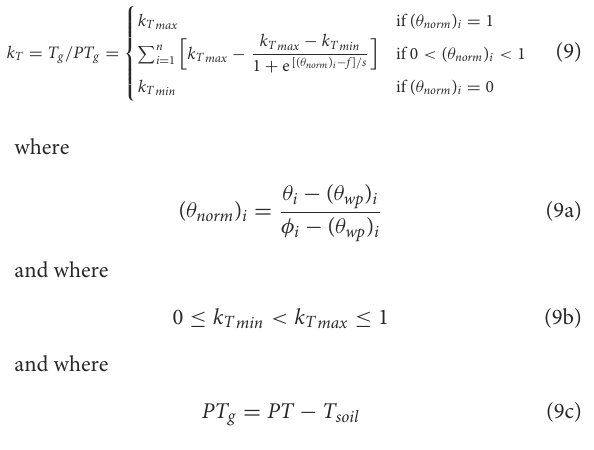
FIGURE5 Sourcing transpiration function (Equation 9) and sensitivity analysis of the plant species sourcing parameters: s , f , k Tmin and k Tmax . (A) k T function of normalized soil moisture ( θ norm ); dots correspond to the observed values of k T pyrenaica ; Q . s ., Quercus suber ), while labels indicate the month of the measurement. (B–D) Time series of transpiration simulation under constant PT = 3.5 mm.d − 1 and declining soil moisture, each with its set of parameters: s , f , k T vadophytic vegetation; PT g , groundwater potential transpiration; T , total transpiration; T soil , soil transpiration; T g , groundwater transpiration. In the simulations, the following parameters were used: porosity φ = 0.45, soil moisture at wilting point θ wp = 0.05 and soil thickness = 1.0